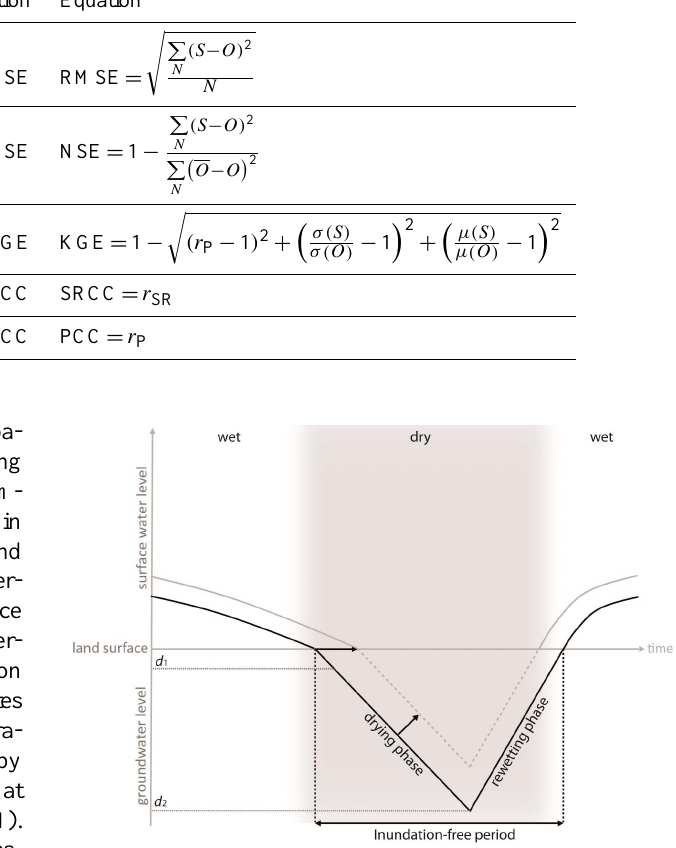
Figure 2. Schematic outline indicating the conceptual model of the Figure 2: Schematic outline indicating the conceptual model of the drying and rewetting 5 drying and rewetting phases of water body D and its application to phases of water body D and its application to other locations with a different inundation 6 dynamic (grey line) 7 other locations with a different inundation dynamic (grey